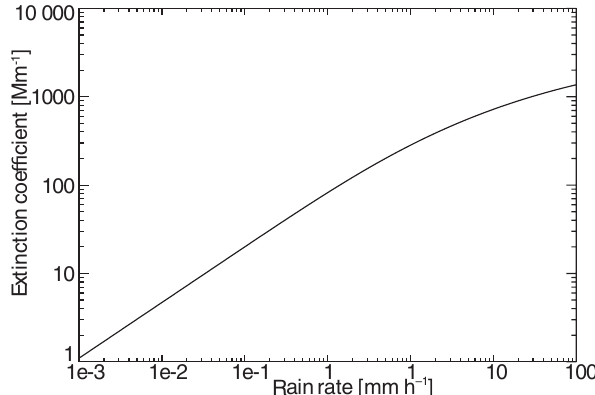
Figure 11. Simulated light extinction coefficient for drizzle in de- pendence of rain